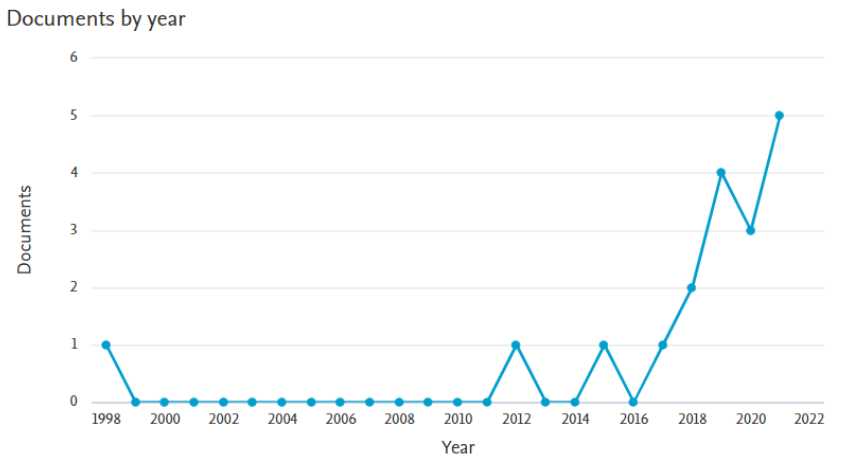
Figure 3. Scopus-indexed publications dedicated to transition strategies in the energy sector as Query 9’s results (Table 1). Source: Scopus database.